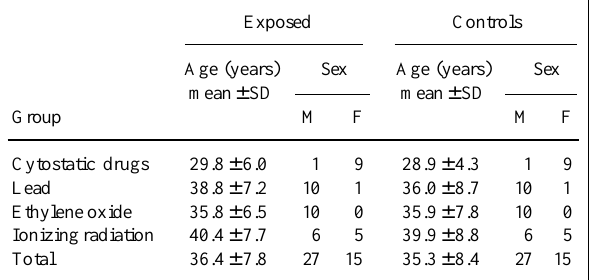
Table I - Age and sex of the hospital workers studied.